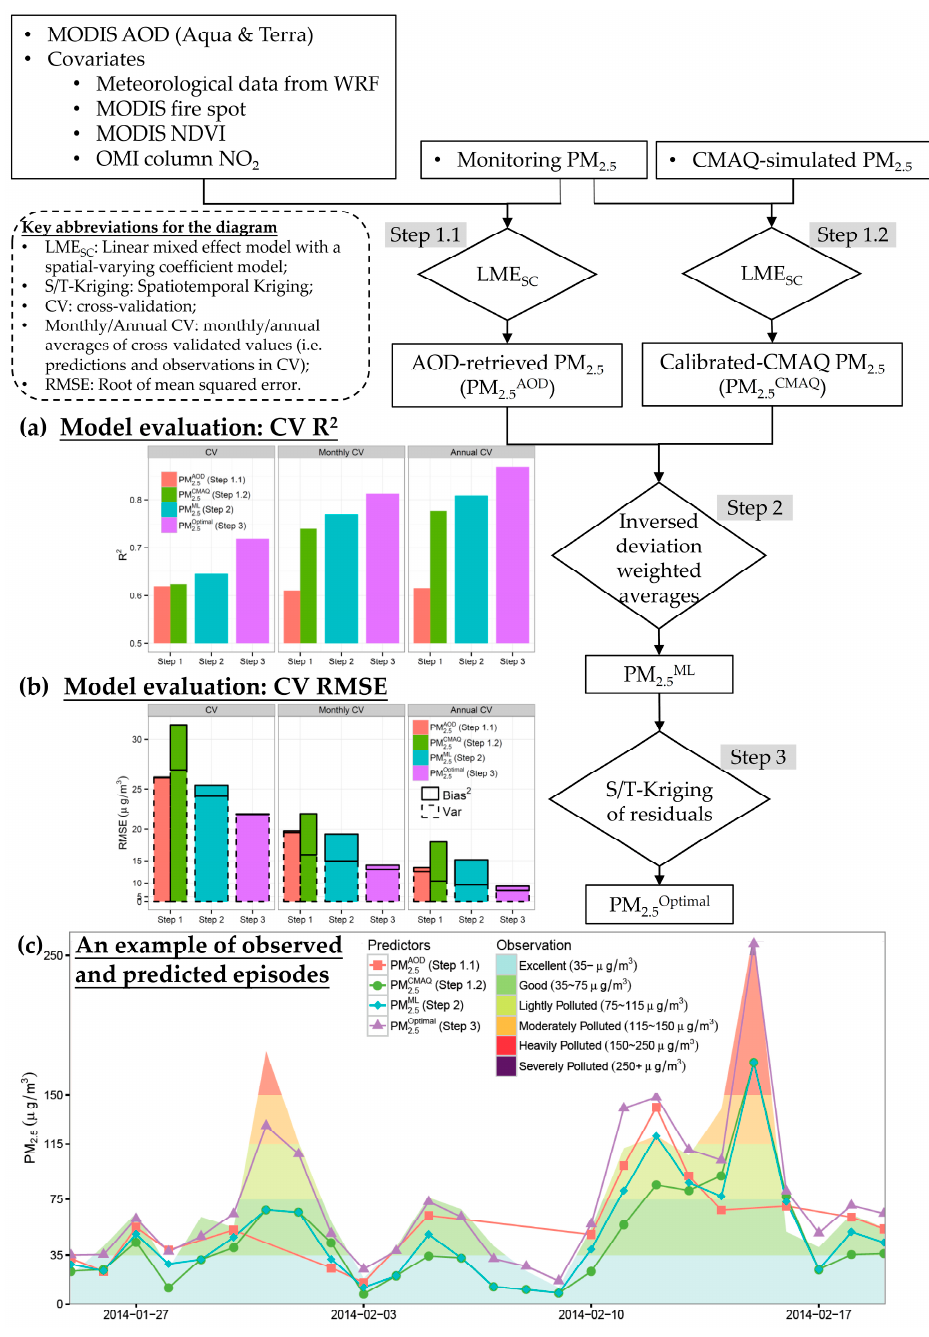
Figure 2. Framework for the three-stage model and cross-validation (CV) results by steps: ( a ) CV R 2 s by steps, where R 2 s were derived based on all available CV samples. ( b ) CV RMSEs by steps, where RMSEs were calculated using the records, in which AOD-derived estimates or their averages exist. Scale of y-axis is logarithm-transformed. Squared RMSE can be divided into two components: squared bias and variance of the estimates, which are highlighted by rectangles in ( b ). ( c ) An example of observed episodes by a CV IS testing site located in (121.12°E, 41.12°N). The corresponding predictors (dots and lines) are presented with the monitoring observations (the polygons filled by colors, which reflect air pollution levels.). The location of the site is visualized by the red box in Figure 8.